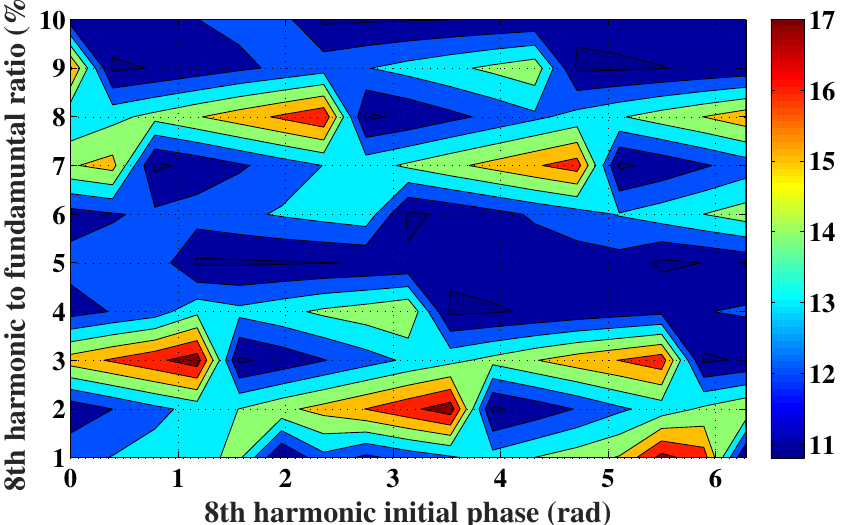
Figure 15. Mapping of the ripple to mean value ratio of the total torque developed following the injection of an harmonic current of rank 8, plotted in the same plane as Figure